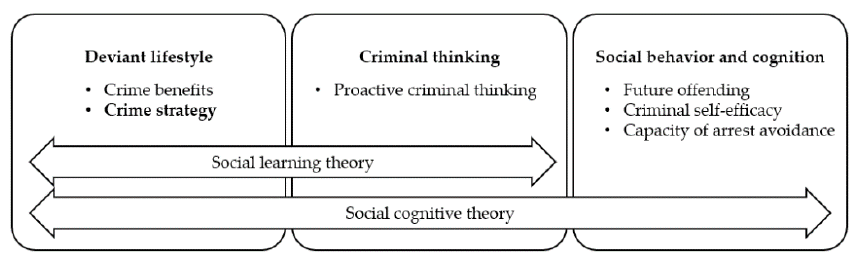
Figure 1. Embedding restrictive deterrence in framework of social learning theory and social cognitive theory.